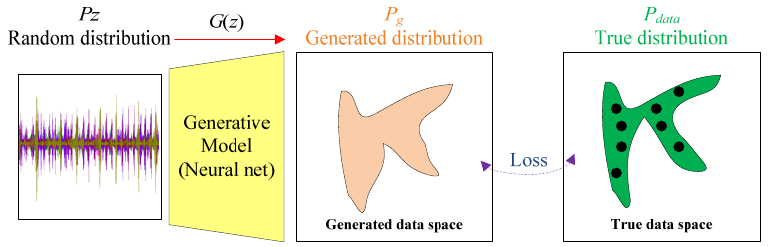
Figure 2. Relationships among the P data . P z , P g and P data.